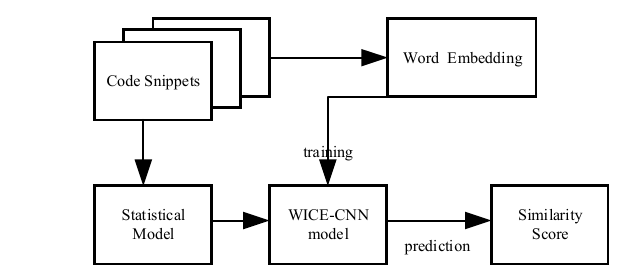
Figure A1. The flowchart of our work.